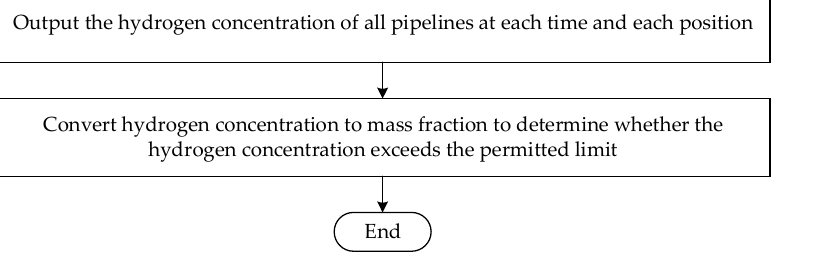
Figure 3. Overall simulation process of hydrogen diffusion in natural gas network.